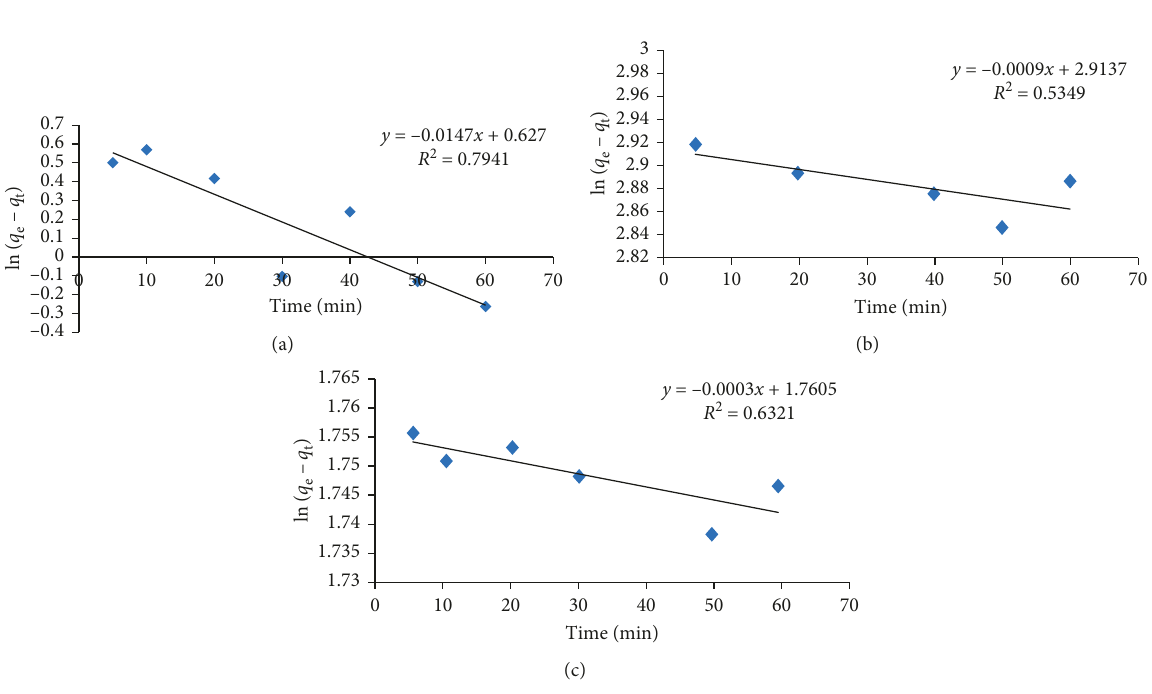
Figure 7: Pseudo-first